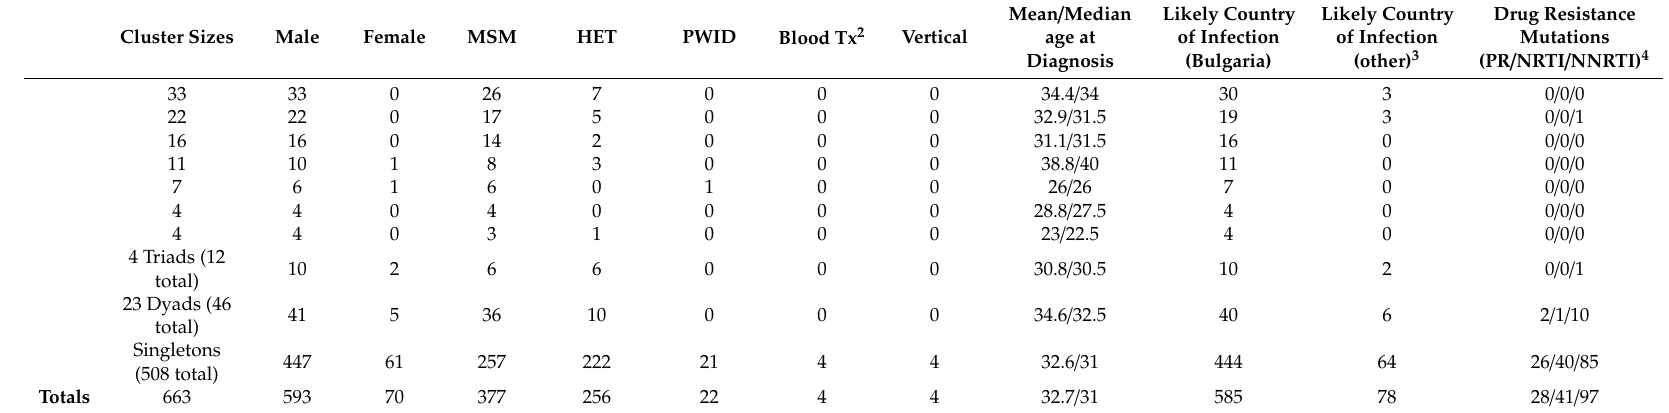
Table 3. Characteristics of HIV-1 subtype B clusters and unclustered persons in Bulgaria, 1988 – 2018, using a genetic distance cuto ff of 0.5% 1 . Cluster